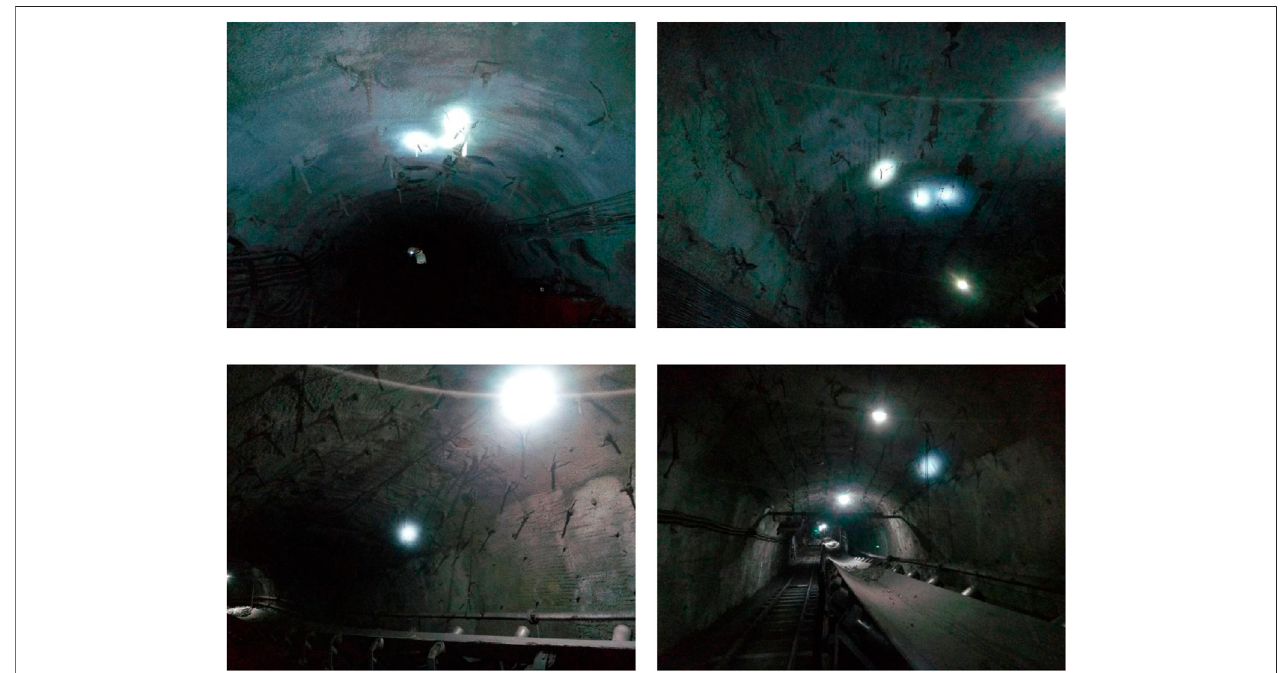
FIGURE 11 | Support effect of the 11 coal belt roadway in the west-east wing of Zhuji.